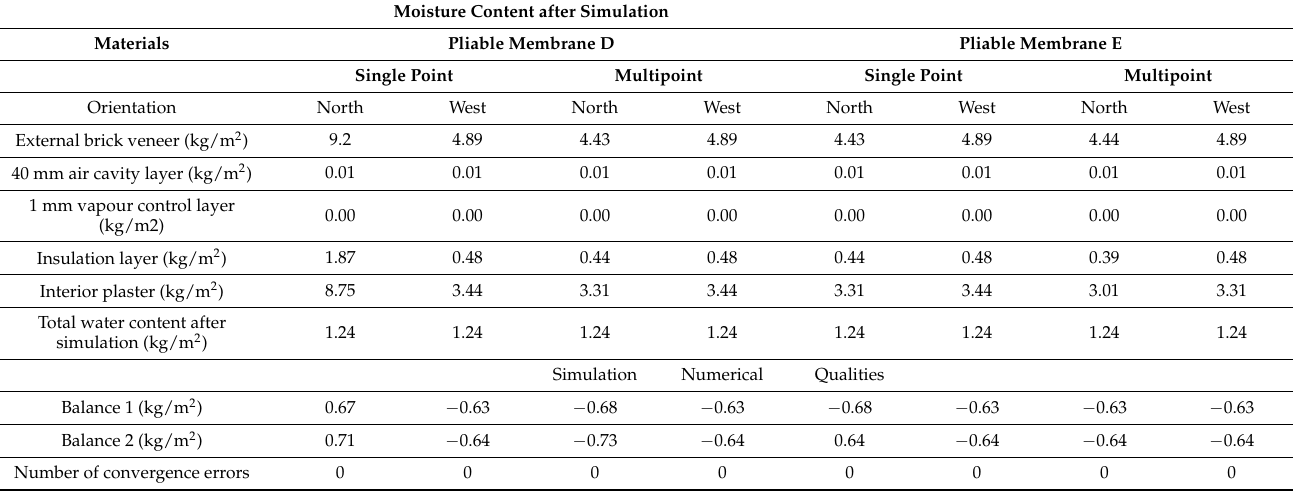
Table A2. Hygrothermal modelling calculation result for Sydney climate on EPW file without rain